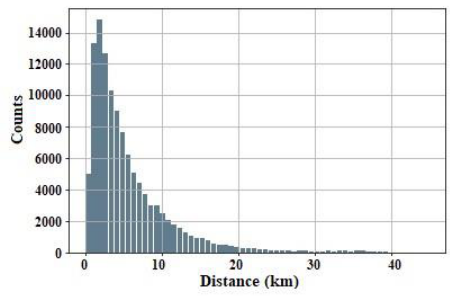
Figure 9. Frequency histogram of travel